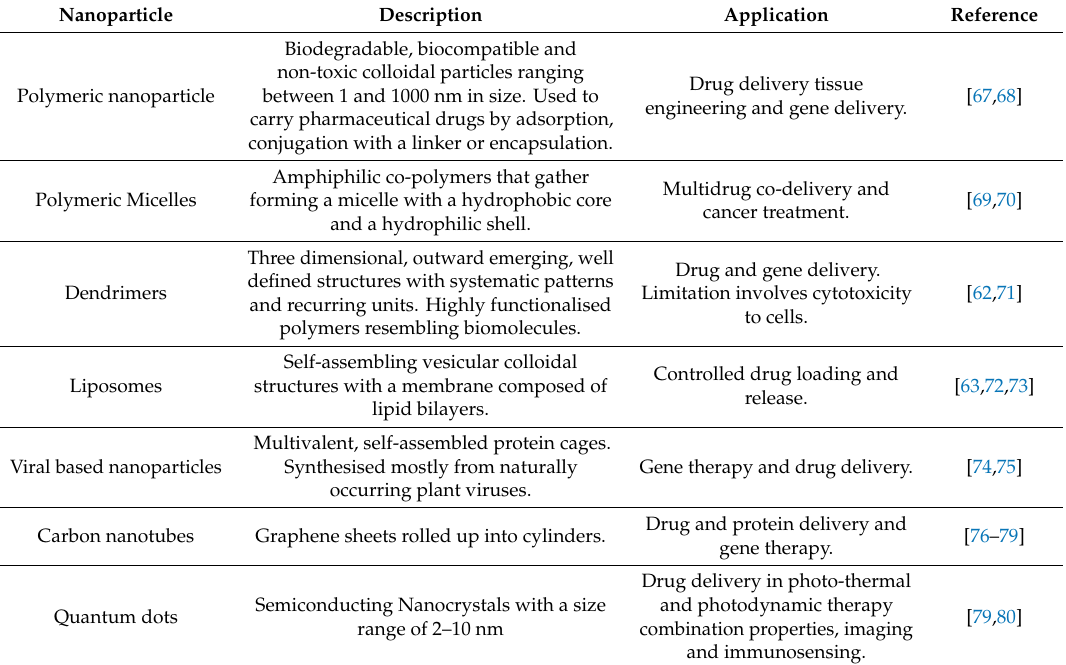
Table 3. Nanoparticles and their